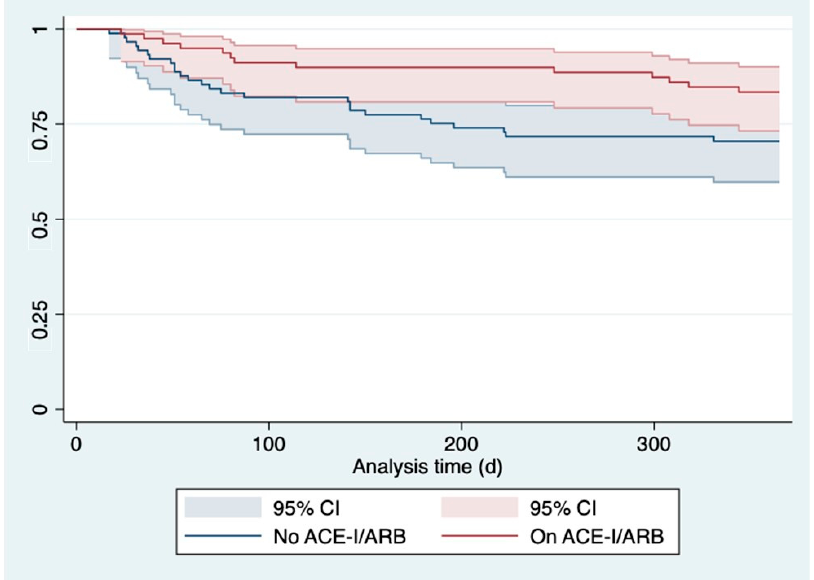
Figure 2. Kaplan–Meier curve illustrating all-cause death or hospitalization due to heart failure dependent on intake of ACE-I/ARB (red line) versus no intake (blue line). Abbreviations: ACE-I ACE-inhibitor; ARB angiotensin receptor